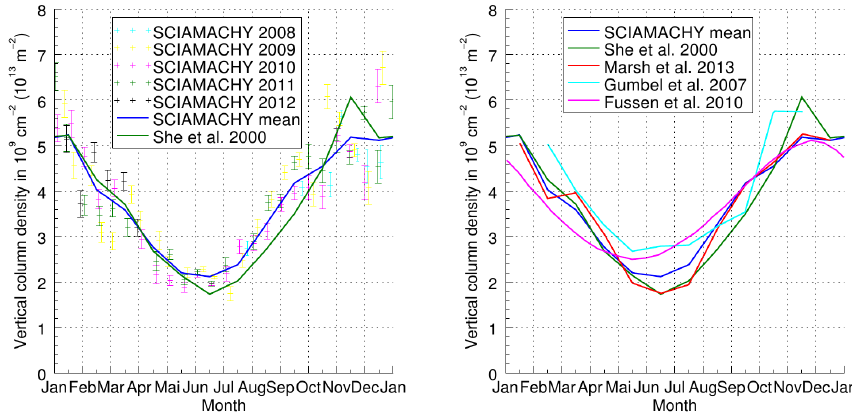
Figure 22. Left: comparison of the SCIAMACHY VCD profile at 40 ◦ N and the results from She et al. (2000). Right: comparison of the same profiles with profiles from Fussen et al. (2010) (their Fig. 7) and Marsh et al. (2013) (their Fig.